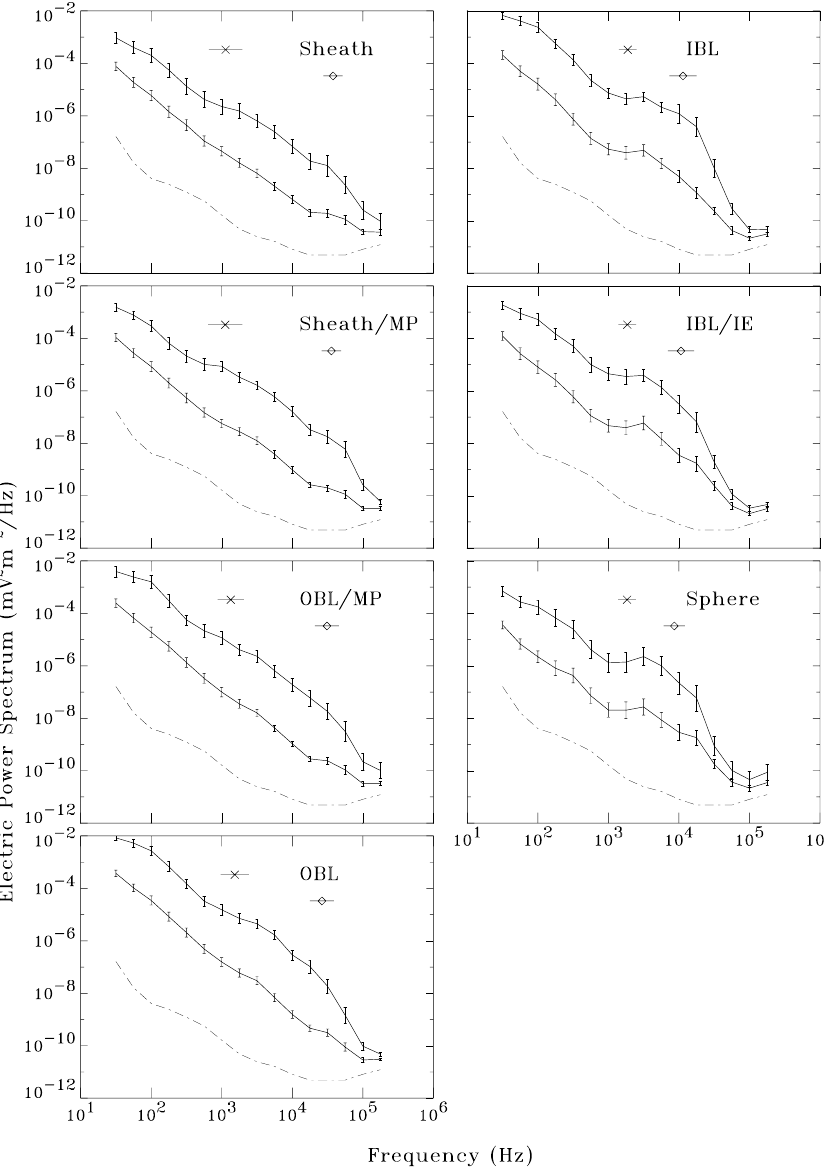
Fig. 9. Spectra of electric fluctuations in the vicinity of the boundary layer aver- aged over the crossings of the data set. Each diagram displays mean values, S E (lower curve), and peak values, ˆ S E (up- per curve), of the electric power spectral density in a normalized time interval. S E is averaged within the interval of one event and then again averaged over all events. For ˆ S E the maximum within the interval is taken for each event and then the maxima are averaged over all events. On the left side, we see from top to bottom average spectra in the magnetosheath ( − 1 < ˆ t < − 0 . 5 ), in the magnetosheath close to the magne- topause ( − 0 . 5 < ˆ t < 0 ), in the sheath- ward half of the OBL ( 0 < ˆ t < 0 . 5 ), and in the earthward half of the OBL ( 0 . 5 < ˆ t < 1 ). On the right side, we see from top to bottom average spec- tra in the sheathward half of the IBL ( 0 < ˘ t < 0 . 5 ), in the earthward half of the IBL ( 0 . 5 < ˘ t < 1 ), and in the magnetosphere ( 1 < ˘ t < 1 . 5 ). Vertical error bars indicate the standard devia- tion of the average of S E and ˆ S E . The dash-dotted line gives the noise level. Crosses and diamonds with horizontal error bars give the average and standard deviation ( ± σ ) of the electron gyrofre- quency and electron plasma frequency,